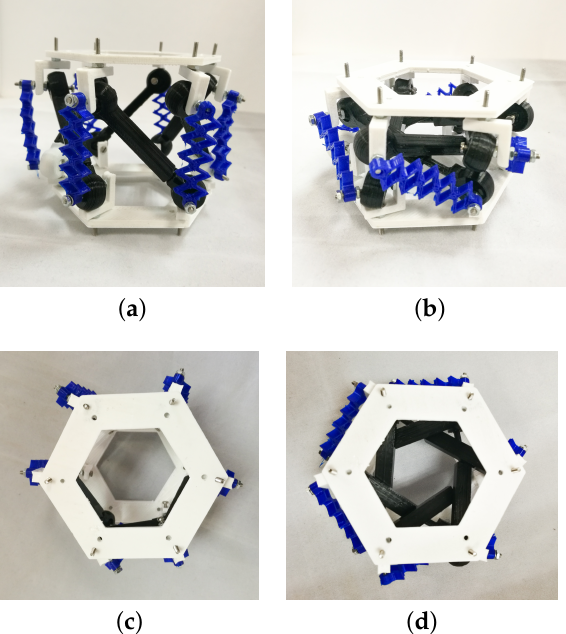
Figure 7. Single link first prototype. ( a ) Deployed single link prototype. ( b ) The single link is in collapsed state, and the height has changed. The l AC pistons are extended and l BC is slightly compressed. ( c ) Top view of the deployed prototype. ( d ) Top view of the collapsed prototype; the condition of the pistons and θ rotation are clearly shown.